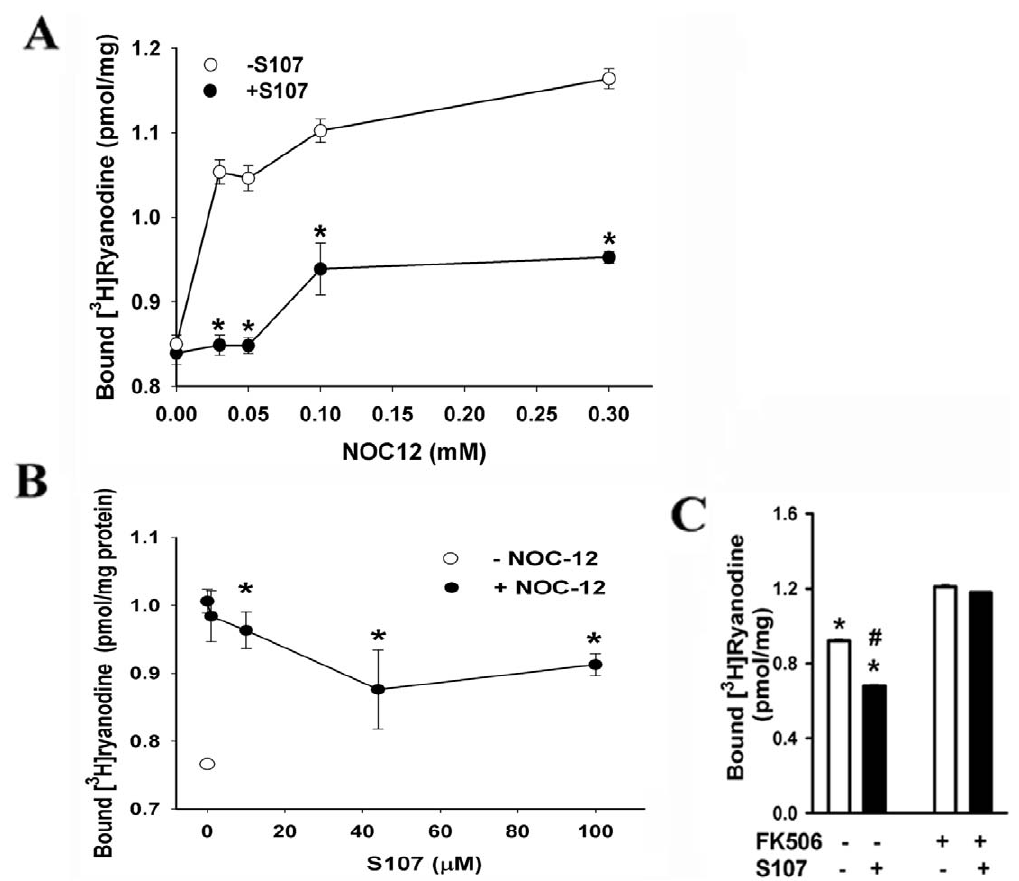
Figure 4. Effects of NOC12 and S107 on [ 3 H]ryanodine binding to RyR1. (A) Dependence of [ 3 H]ryanodine binding on NOC12 concentration. N SR vesicles not treated with FK506 were incubated for 5 h at 24 u C in 0.25 M KCl, 20 mM imidazole, pH 7.0, 7 m M free Ca 2 + , protease inhibitors and the ) and absence ( # ) of 44 m M S107. Data are the mean 6 SEM of 4 experiments. *p , 0.05 indicated concentrations of NOC12 in the presence ( N compared to vesicles without S107. (B) Dependence of [ 3 H]ryanodine binding to RyR1 on S107 concentration. SR vesicles were incubated as in A in ) and the indicated concentrations of S107. Data are the mean 6 SEM of 4 experiments. *p , 0.05 the absence ( # ) and presence of 50 m M NOC12 ( compared to vesicles with 50 m M NOC12 and without S107. (C) Specific [ 3 H]ryanodine binding to SR vesicles containing ( 2 FK506) and depleted ( + FK506) of FKBP12. [ 3 H]Ryanodine binding was determined in the presence of 50 m M NOC12 and the absence and presence of 44 m M S107. Data are the mean 6 SEM of 8 experiments. *p , 0.05 compared to vesicles treated with FK506 and incubated in the absence of S107, # p , 0.05 compared to vesicles not treated with FK506 and incubated in the absence of S107.